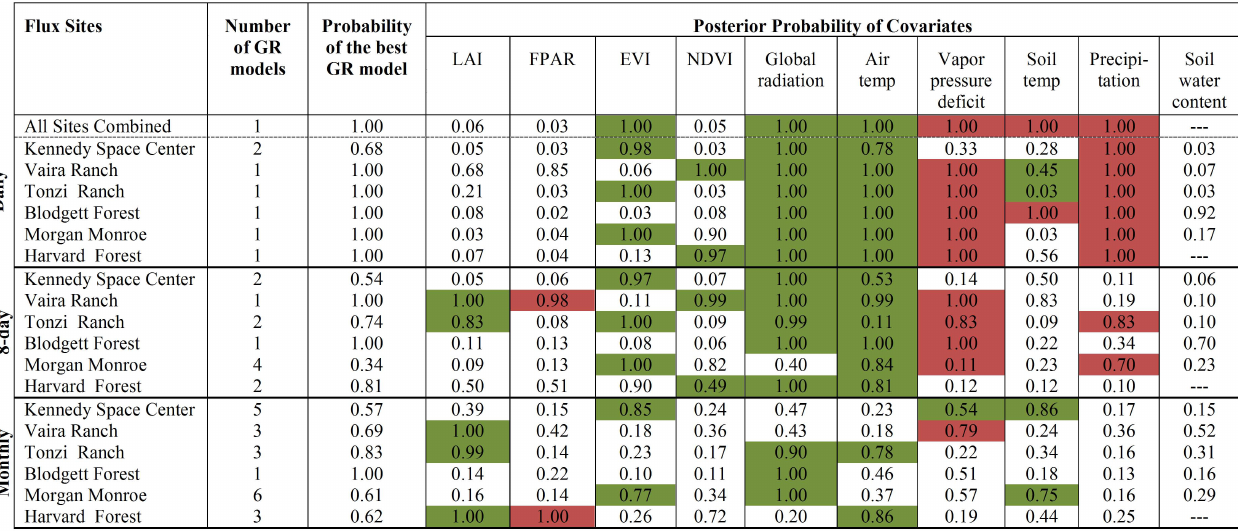
Table 2. Final number N of geostatistical regression (GR) models considered, and the posterior probability of the “best” model (see Eq. 11 and subsequent text) at the daily, 8-day and monthly scales. The posterior probability of the covariates (see Eq. 12 and Sect. 3.4) is shown for all covariates. The covariates that are included in the “best” GR model are shaded, with green indicating a positive correlation with